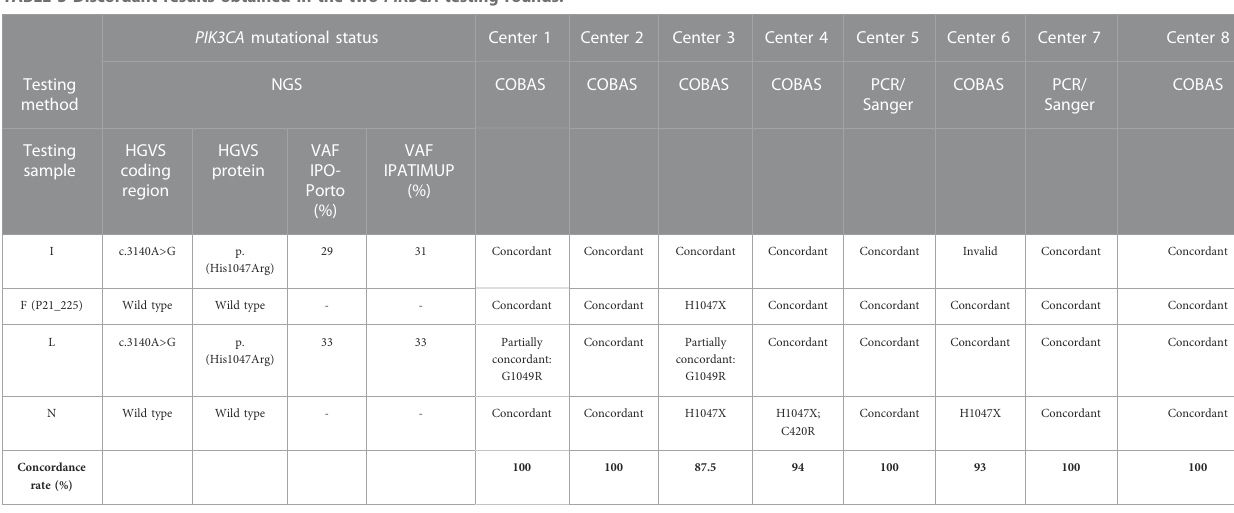
TABLE 3 Discordant results obtained in the two PIK3CA testing